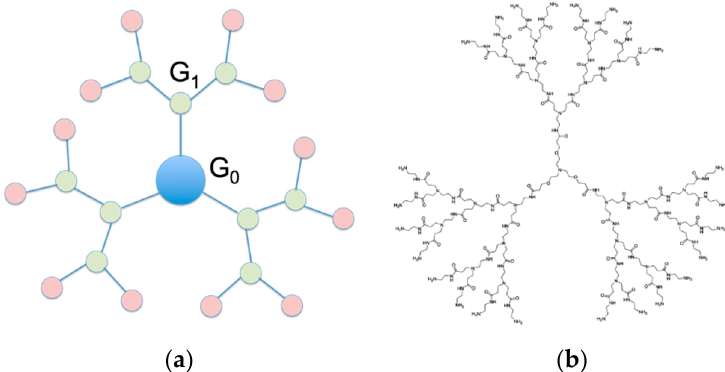
Figure 1. ( a ) Cartoon representation of a dendrimer structure highlighting its three, distinct structural motifs: The core (in light blue), the branching units forming the different G generations (in light green), and the terminal groups (in light pink). According to a consolidate dendrimer nomenclature, the core constitutes Generation 0 (G 0 ). Therefore, the subsequent Generations G 1 , G 2 , ... G n refer to the corresponding level of branching, as annotated in panel ( a ). ( b ) Molecular structure of the triethanolamine (TEA)-core poly(amidoamine) dendrimers. For clarity, in panel ( b ), only a dendrimer of Generation 4 (G 4 ) is shown.